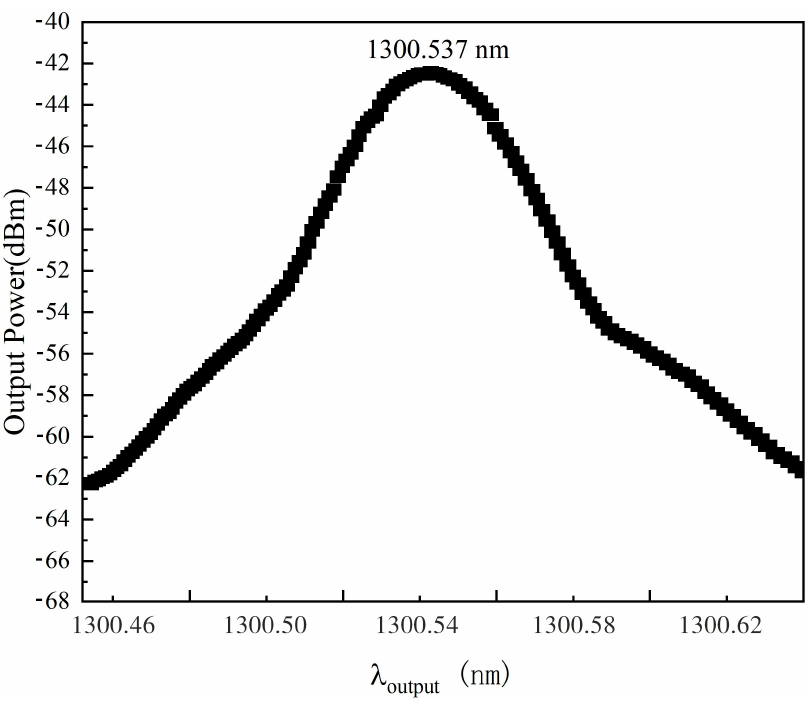
Figure 5. The figure shows the spectrum of the outgoing light, with the peak value of the output wavelength around 1300.537 nm.